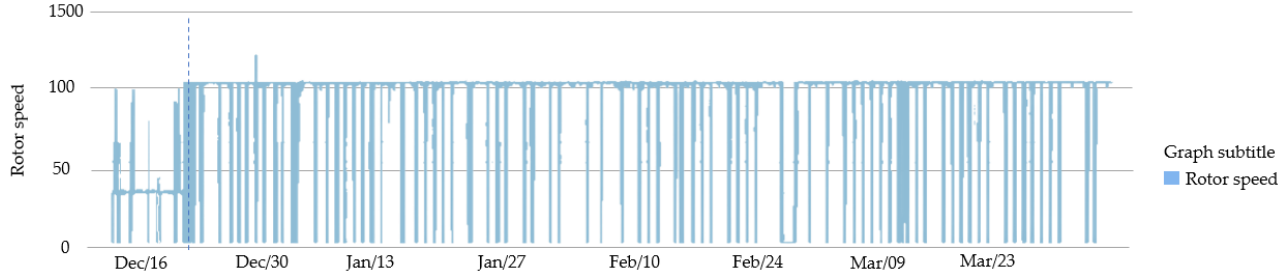
Figure 15. Frequency inverter monitoring by the smart sensor.